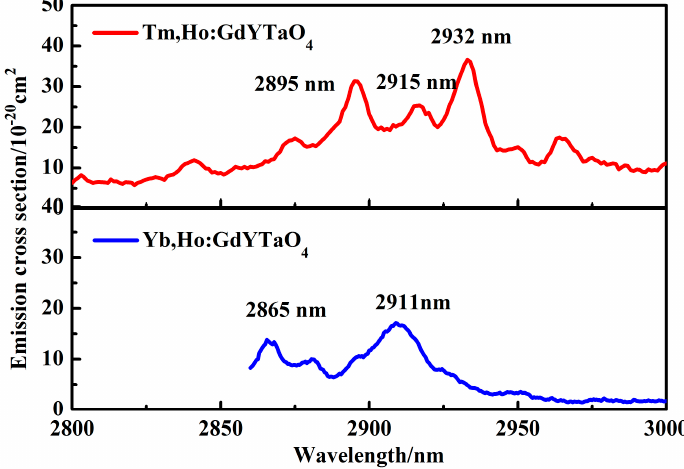
Figure 5. Emission cross-section spectra of Tm,Ho:GdYTaO 4 and Yb,Ho:GdYTaO 4 crystal at room